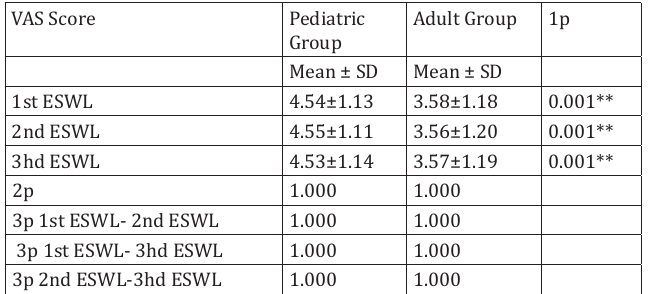
Comparison of the VAS Scores related to ESWL Sessions between and within the Pediatric Group and Adult Group